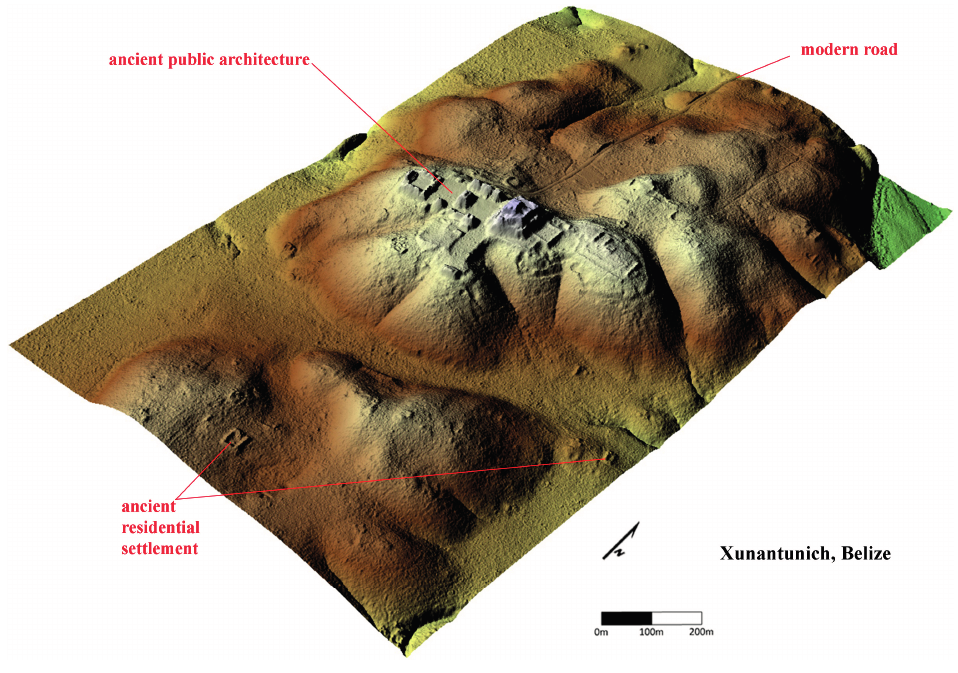
Figure 10. 2.5D LiDAR bare earth rendering of the hilltop site of